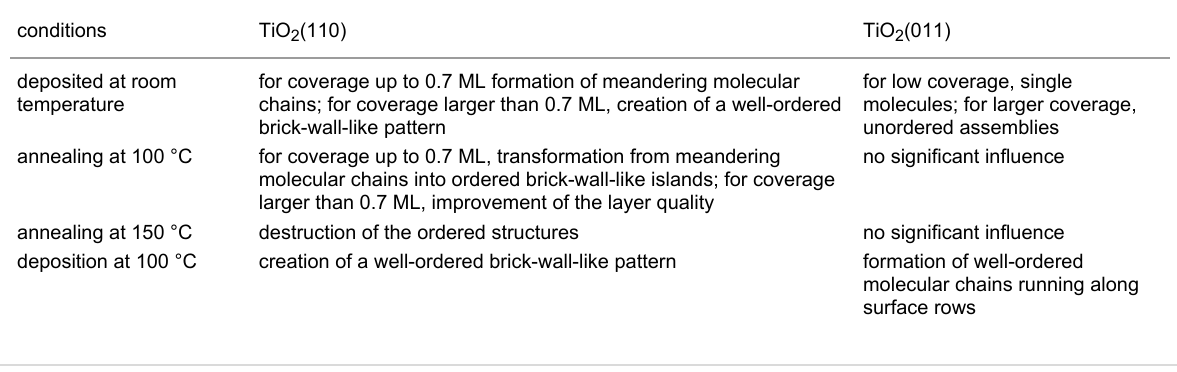
Table 1: Molecular structures formed by PTCDA molecules under different conditions on TiO 2 (110)-(1 × 1) and TiO 2 (011)-(2 × 1).